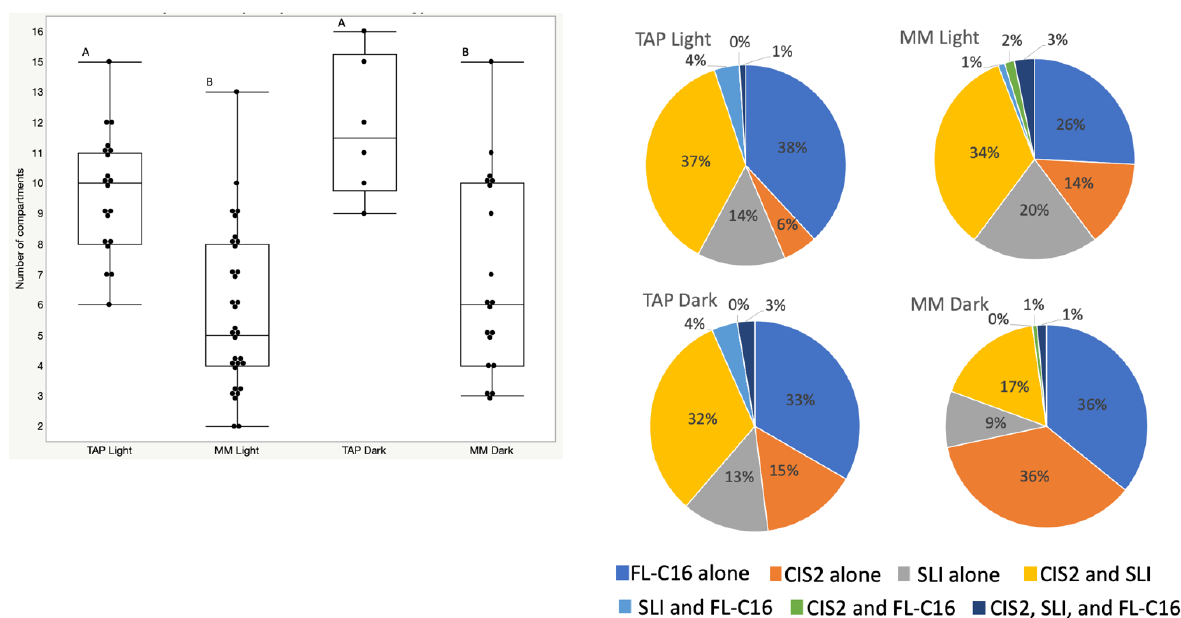
Figure 3. Statistical analysis revealed alteration of peroxisomal content by light conditions. ( A ) Schematic of fluorescently labeled palmitic acid (FL-C16) pulse experiment. C. reinhardtii expressing both CFP-SLI and CIS2-RFP was cultured in TAP with FL-C16 for 8 h, then transferred to a fresh medium under four different conditions for 24 h before imaging: TAP with continuous light, minimal medium (without acetate, MM) with continuous light, TAP in the dark, and MM in the dark. ( B ) Localization of FL-C16 and peroxisomal marker proteins after 24 h in each condition. Thirty optical sections of each 20 µ m z-stack are projected into one image with their maximum intensity. Co-localizations of all three markers are rarely observed, indicated by white arrows. ( C , D ) Thirty optical sections within the 20 µ m z-axis were obtained by confocal microscopy. Colocalization in the optical sections was analyzed with ComDet (ImageJ plugin for analyzing colocalization of bright intensity spots). Mean of the spot number, standard error of the mean, numbers of cells, and optical sections for the analysis are, TAP with continuous light (TAP Light: mean 9.7, S.E. 0.47, 8 cells, 20 sections), MM with continuous light (MM Light: mean 5.75, S.E. 0.46, 7 cells, 32 sections), TAP in the dark (TAP Dark: mean 12.1, S.E. 2.78, 3 cells, 6 sections), and MM in the dark (MM Dark: